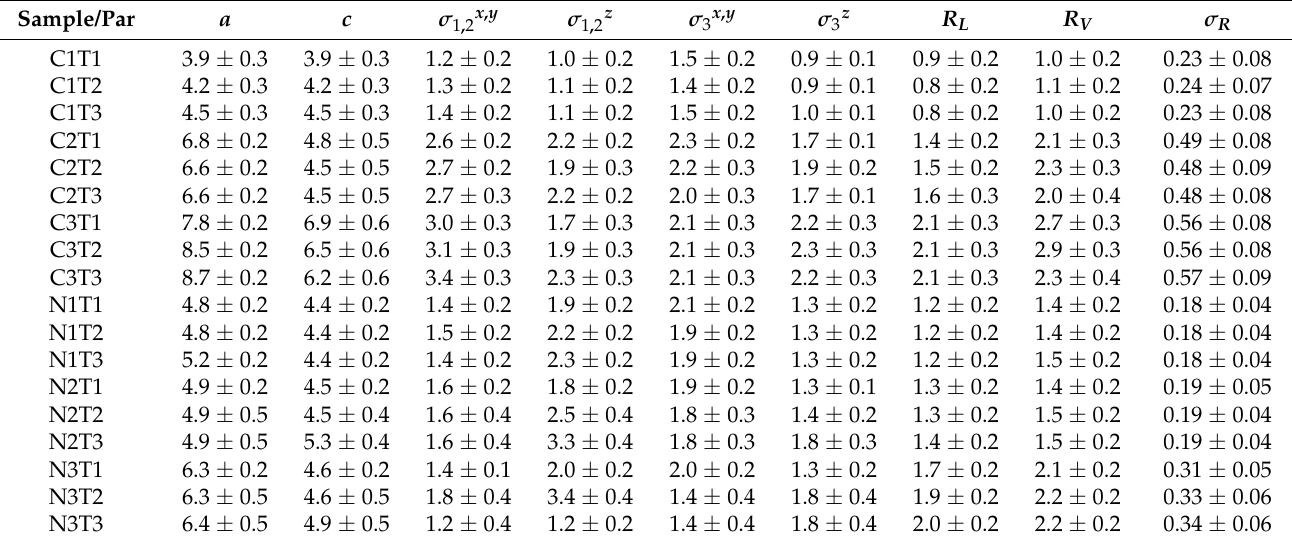
Figure 1. GISAXS maps of the investigated films. ( a ) Au NPs in SiC matrix, ( b ) Au NPs in Si 3 N 4 matrix. The insets show the simulated GISAXS maps calculated using the parameters of the fit, given in Table 2. Table 2. Parameters of the Au QD lattices found by GISAXS analysis and their errors. a and c are the lateral and vertical separation of Au NPs, respectively. σ 1 − 3 x , y , z are the deviation parameters, σ R is standard deviation of the size distribution, and R L and R V are the Au NP lateral and vertical radii, respectively. All values are given in